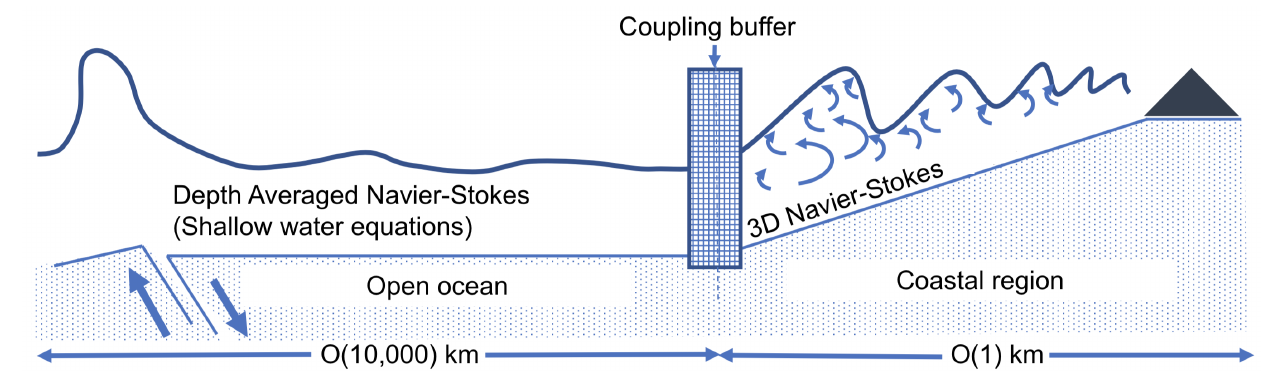
Figure 5. Representation of a comprehensive off-to-on-shore flow framework. The 3D Navier–Stokes solver is forced at the boundaries by the shallow water model of the tsunami off-shore, which is forced by an earthquake simulator. In fact, the 2D shallow water solver can extend all the way into the shore depending on the needs of the solver and compatibility